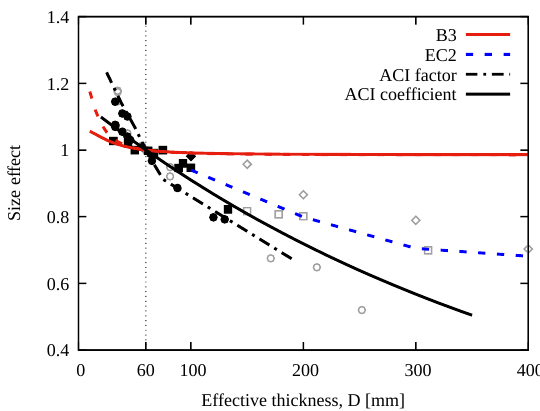
Figure 5. Comparison of the size effect according to the design codes and recommendations (curves) with the experimental data (filled black symbols = finished shrinkage, empty grey symbols = prematurely termi- nated experiments). The functions and the data are normalized with respect to the size D = 60